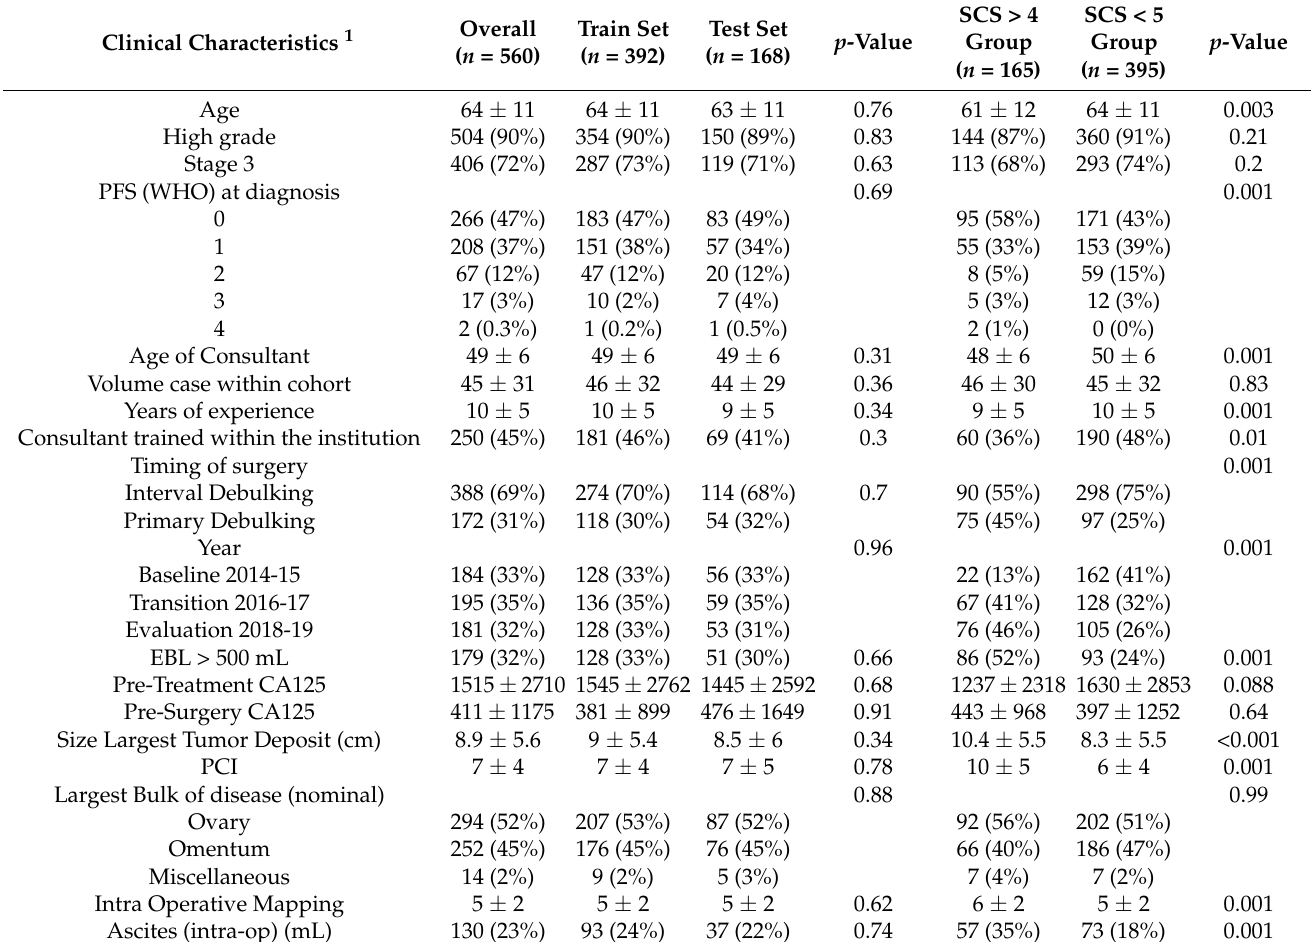
Table 1. A Two Independent Sample t Test was used for continuous variables, whereas a Chi-Squared Test of Independence was used for categorical data. Statistical analysis was performed using Python’s SciPy library. Values are mean ± SD or n